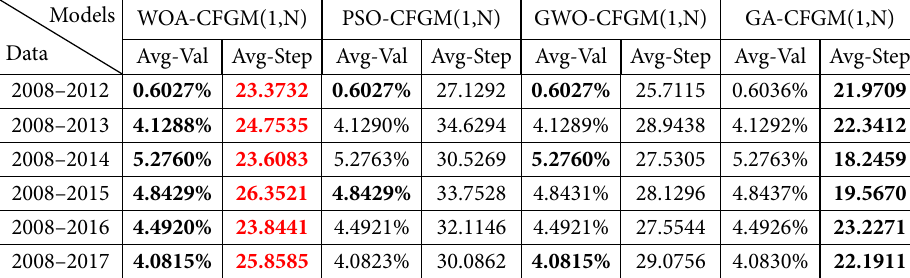
Table 4. The comparison about these four heuristic algorithms